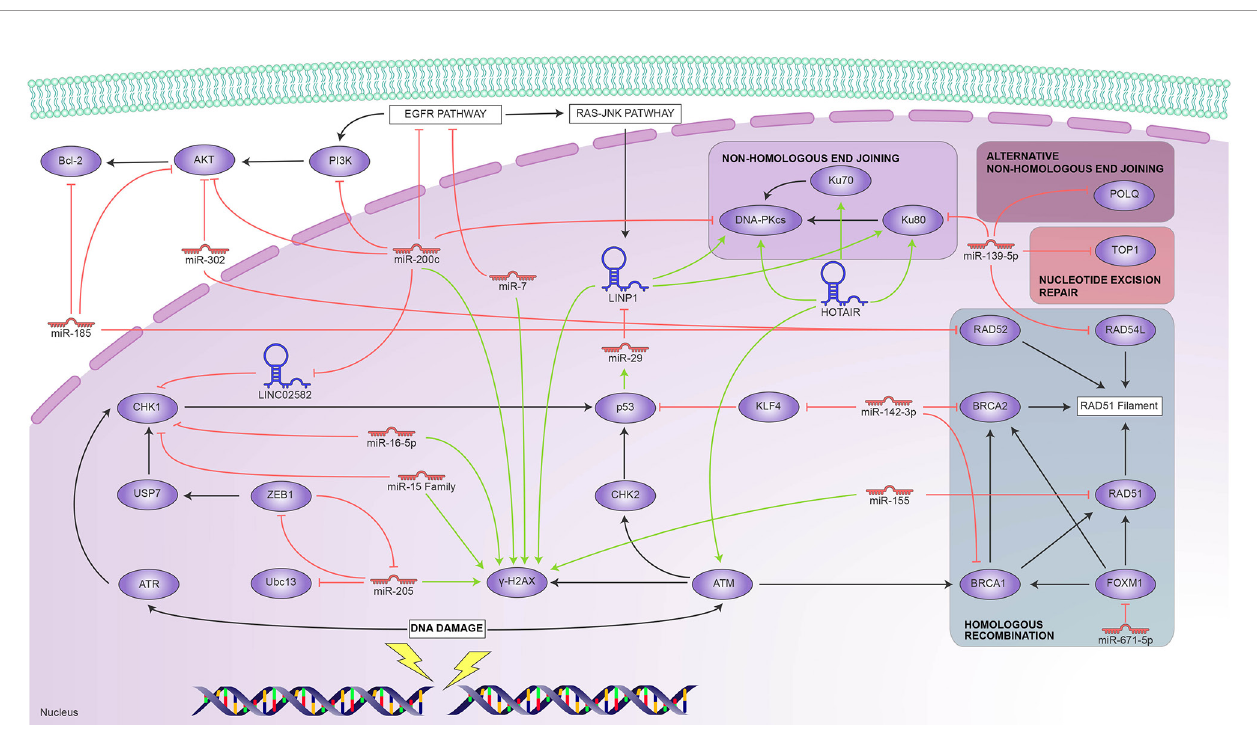
FIGURE 1 | Reported ncRNAs that regulate DNA damage response and their targets. Green arrowheads represent positive regulation and red bars, negative